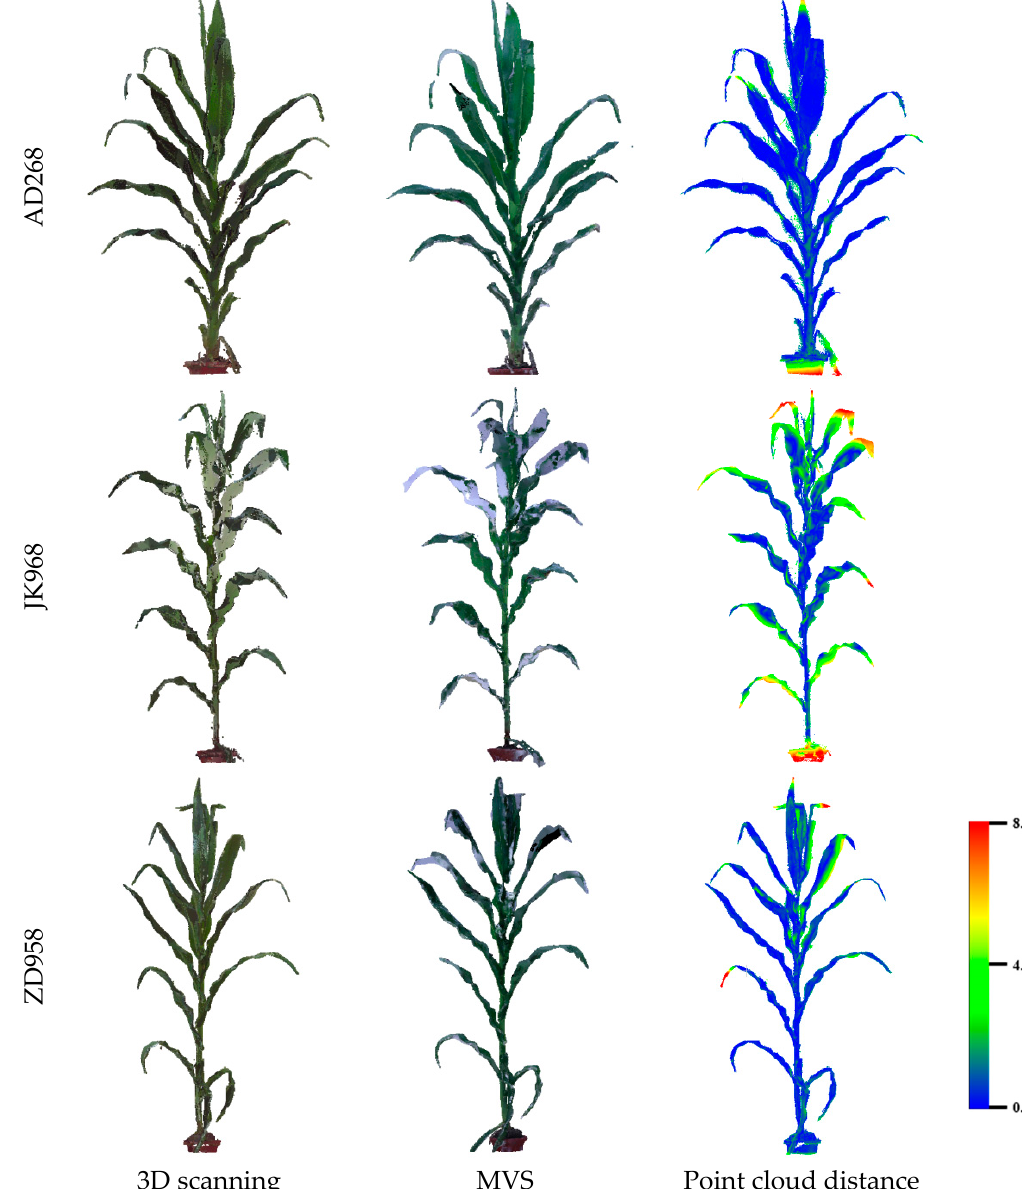
Figure 5. Maize plants point clouds comparison derived using 3D scanning and MVS reconstruction at V15 stage (50th day after sowing).